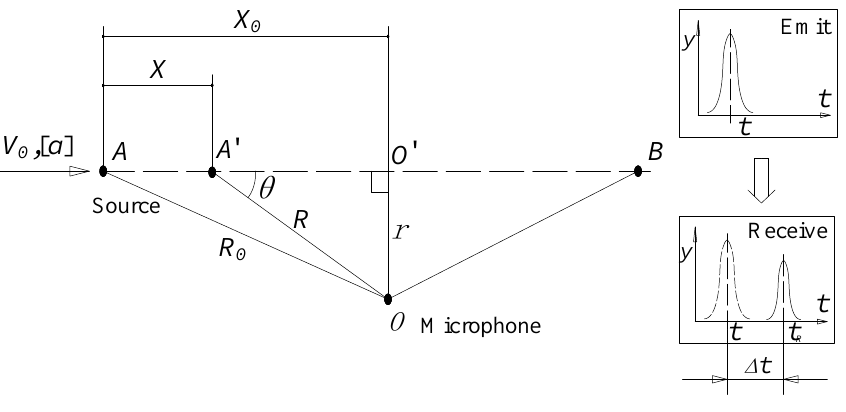
Figure 1. Basic kinematic model of the wayside acoustic bearing monitoring